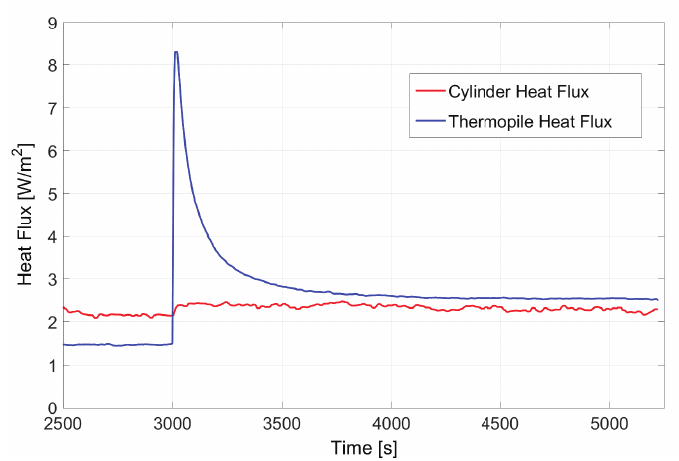
Figure 11. Open loop experimental results. The cylinder heat flux is monitored using the PT500 resistors at its bottom and top surfaces. At approximately t = 3000 s the thermopile is placed on top of the cylinder. The heat flux estimated by the thermopile is obtained by monitoring its open circuit voltage, ∆ V ( t ) , as Φ ( t ) = ∆ V ( t ) / S , where S is the sensitivity of the